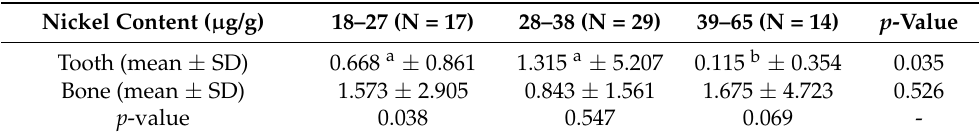
Table 14. Nickel content in tested samples taken from patients of different age.